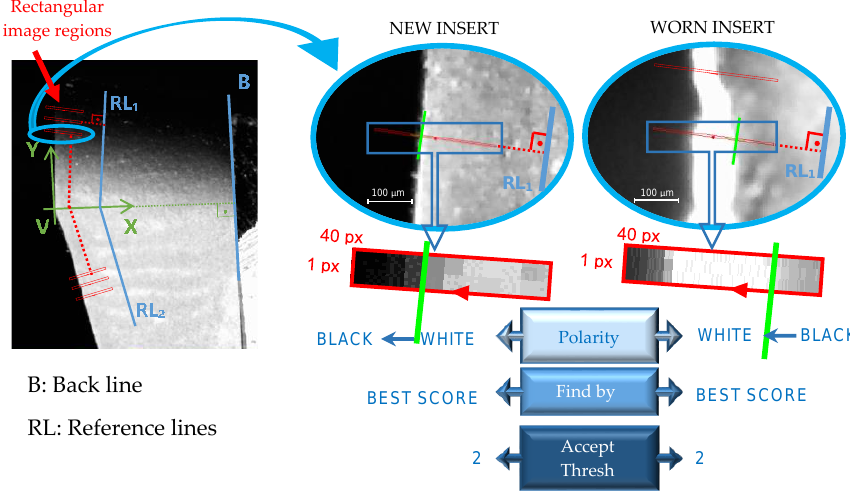
Figure 12. Pixels identification of the border on the tool cutting edge on radial flank images.